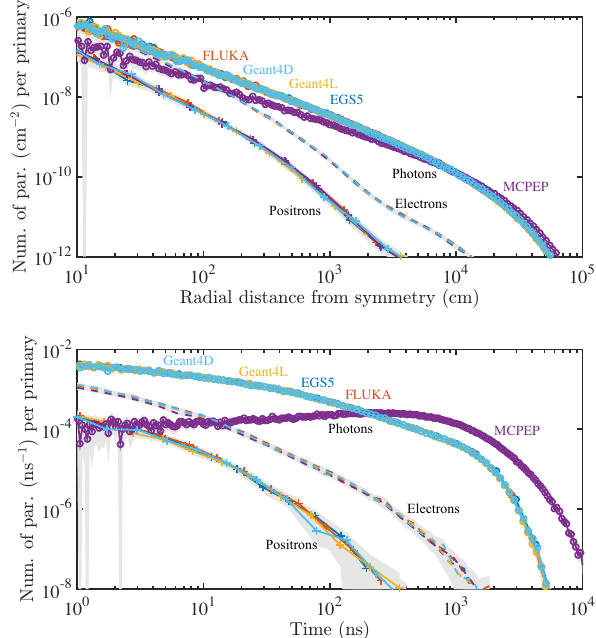
Figure 4. Products of a beam of 10MeV photons at a distance of 1/(0.5µ) which corresponds to 756m (1bar and 273K). Particle number per primary is a function of the radial distance from the symmetry axis (above) and arrival time